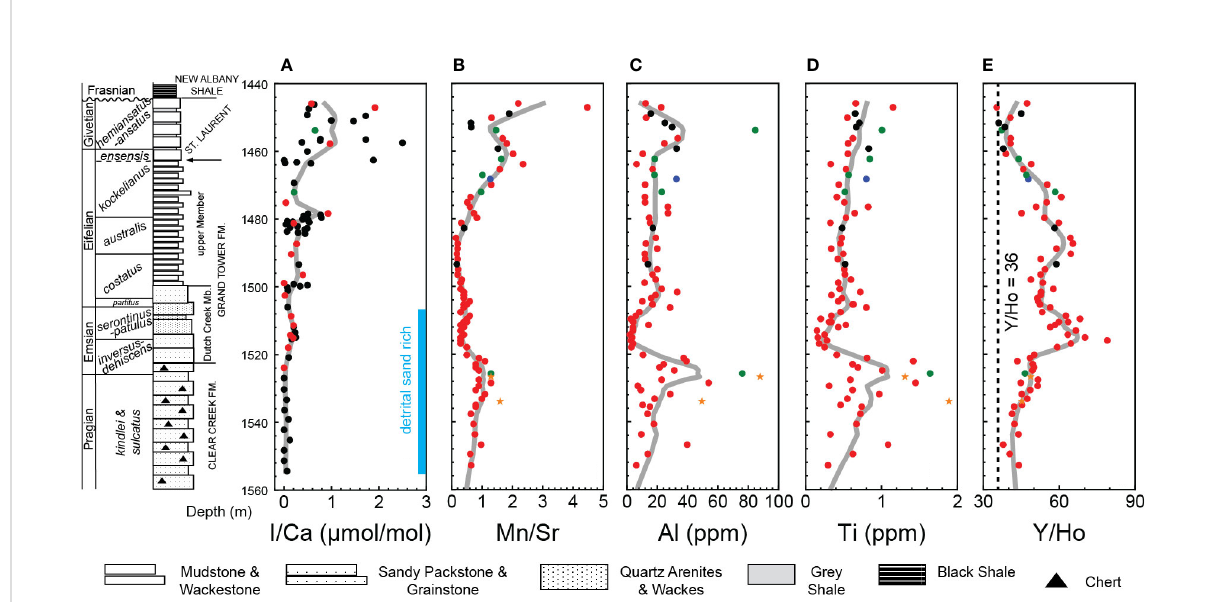
FIGURE 4 Geochemical measurements from the Illinois Basin core. (A) Carbonate lithology-speci fi c I/Ca ratios, (B) Mn/Sr ratios, (C) Al concentration, (D) Ti concentration, (E) Y/Ho ratios. The gray curves show the results of LOWESS smoothing. The black dashed line in (E) shows Y/Ho = 36. Values higher than 36 indicate primary marine REEs signals [e.g., Ling et al. (2013)]. Note all the results were measured from the carbonate fraction. The Pragian-Emsian portion is rich in quartz sands (blue vertical line). Samples of (A) and samples of (B – E) are from the same core but not measured from same depth. Color code for lithological groups: grainstone (red), packstone (blue), wackestone (green), lime mudstone (purple), unassigned (black). Brown stars in Pragian of (B – E) represent quartz sandstones with calcite